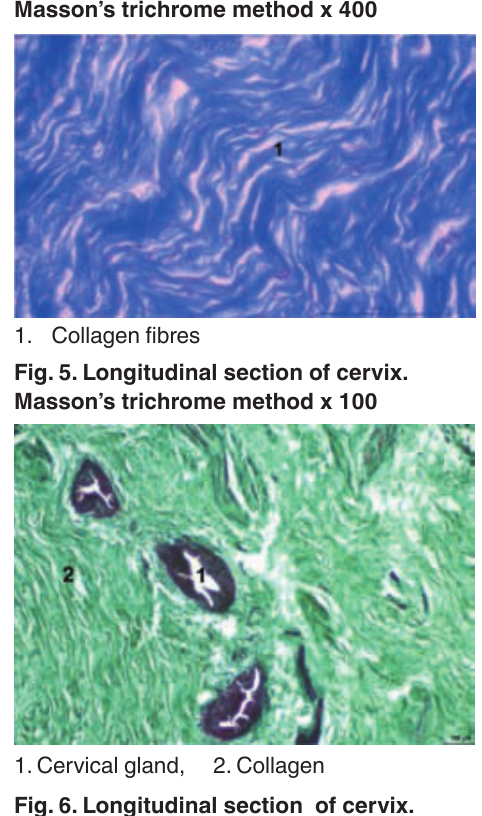
Fig. 4. Longitudinal section of cervix.